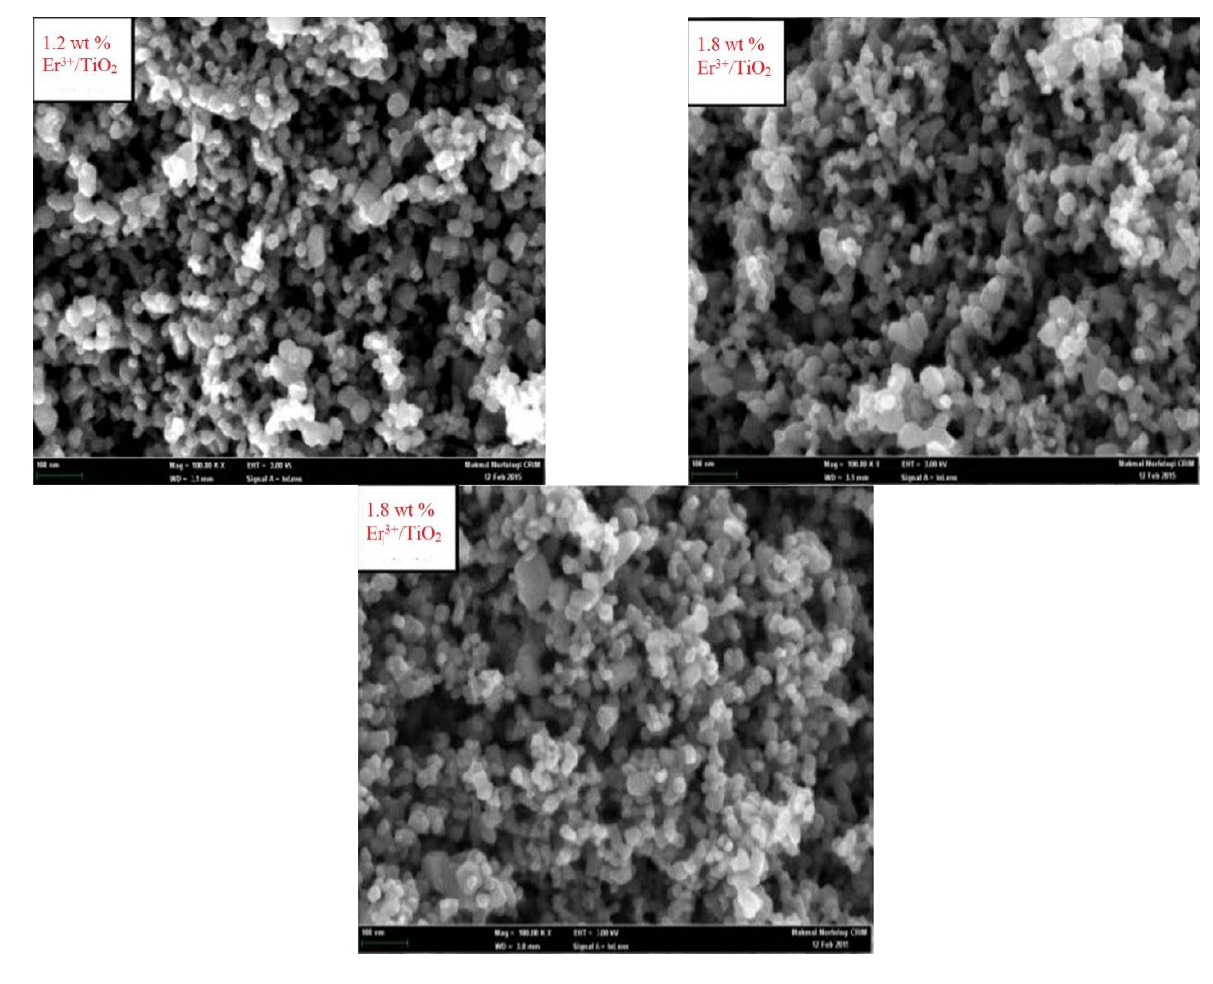
Figure 2. FESEM micrographs for the synthesized samples. Table 3. EDX analysis of the theoretical and empirical values of the synthesized samples.